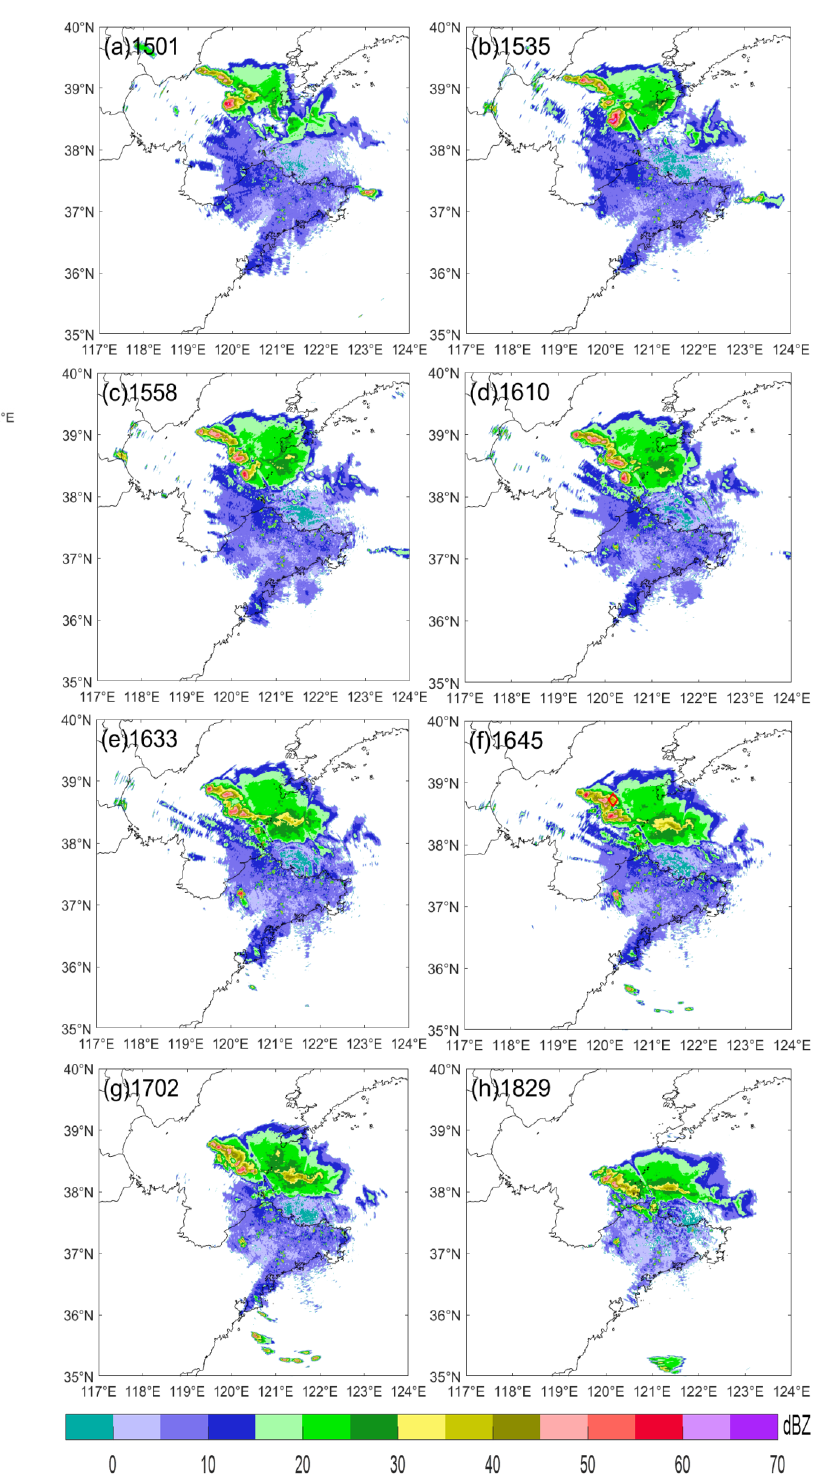
Figure 6. Evolution of composite radar reflectivity of the sprite-producing thunderstorm at ( a ) 15:01, ( b ) 15:35, ( c ) 1604, ( d ) 1645, ( e ) 1720, ( f ) 1829 May 31, 2017. the “ ◇ ” stands for the location of sprite-producing +CG. The upper left corner (cid:51) indicates that a thunderstorm occurred in the border of Inner Mongolia Autonomous Region, Hebei Province, and Liaoning Province.